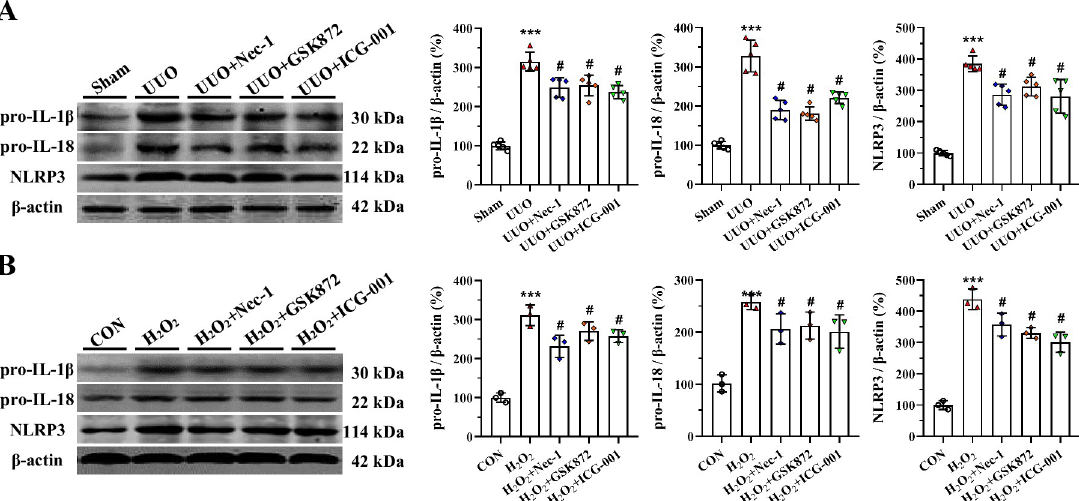
Fig 2. Representative photomicrographs of immunoblotting analysis of pyroptosis-related cytokines in vivo (A) and in vitro (B). ��� P < 0.01 vs. sham or control; # P < 0.05 vs. UUO or H 2 O 2 .